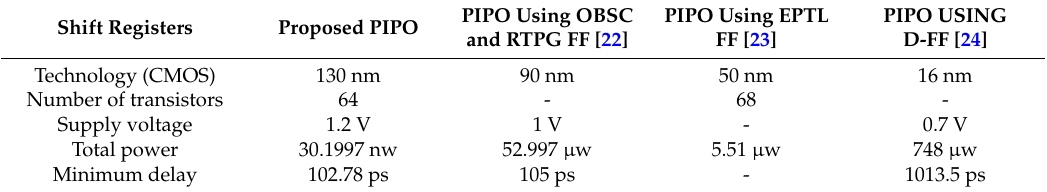
Table 2. Performance comparison among different parallel in-parallel out (PIPO) shift registers.